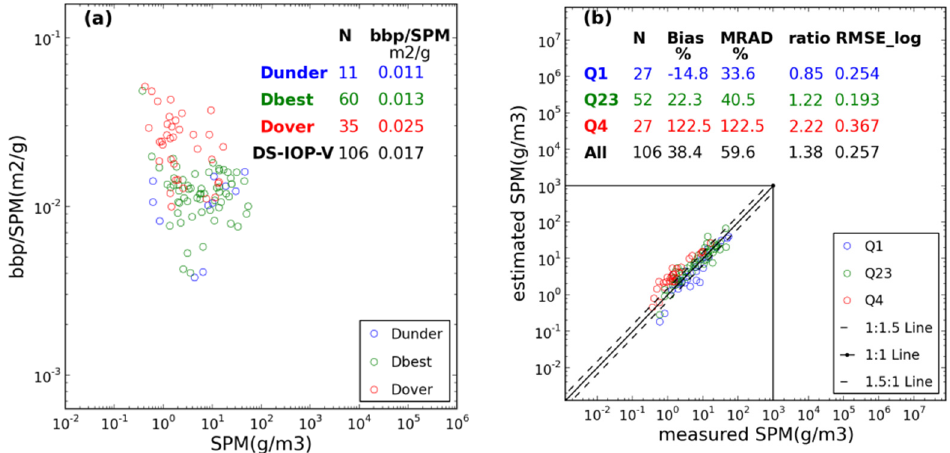
Figure 10. ( a ) Repartition of the b bp / SPM values when SPM is over estimated (red dots), under-estimated (green dots), well estimated (see text); ( b ) Comparison of the measured and inversed-SAA SPM values. The points belonging to each of the four defined quartile are represented as indicated. The values of the statistical indicators are provided for each quartile. Solid lines represent 1:1 line and dashed lines represent 1.5:1, 1:1.5 lines.